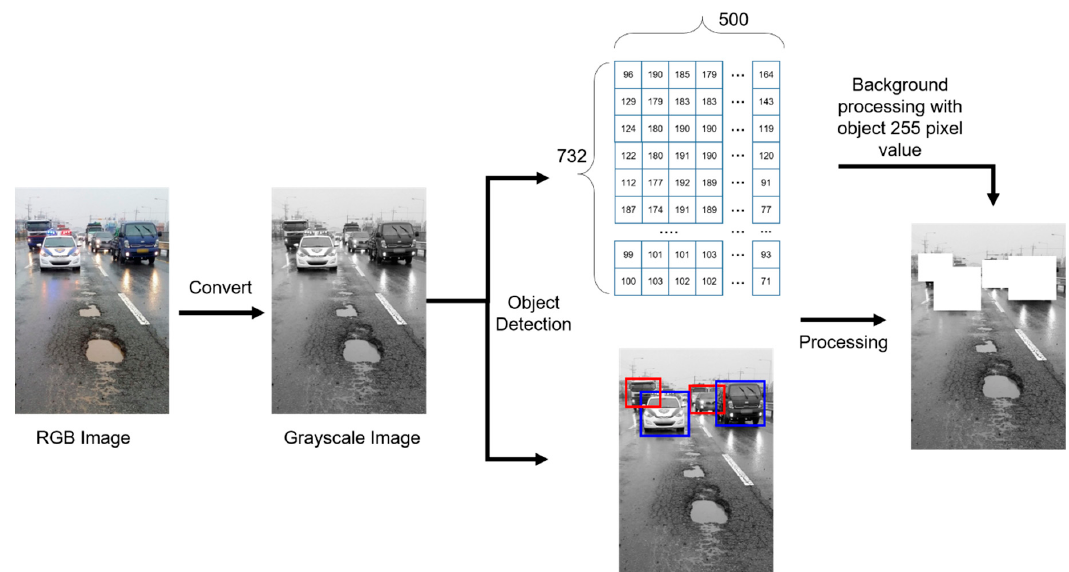
Figure 2. Pre-processing process using object detection.